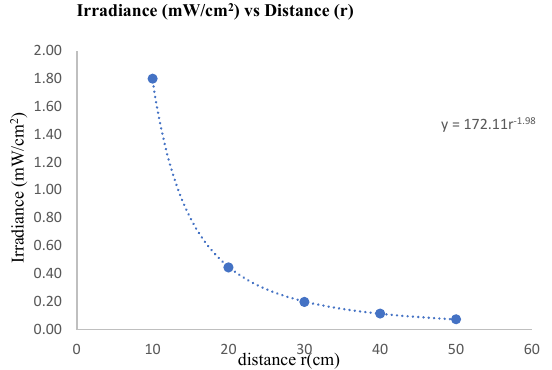
Figure 6. The graph shows the relationship between the irradiance and distance for the DIEHL 405 nm LED. Illustration of the inverse square law for calculating the irradiance at varying distances. Table 2. Irradiances (W/cm 2 ) for different UVCs radiations and blue light. Distance between the Virus Sample and Light Source